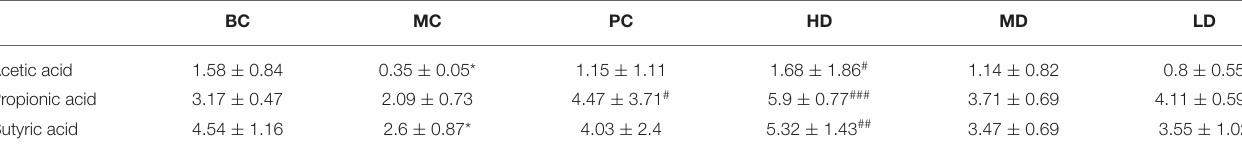
TABLE 3 | Effect of F. velutipes polysaccharide on the content of SCFAs. BC MC PC HD MD LD Acetic